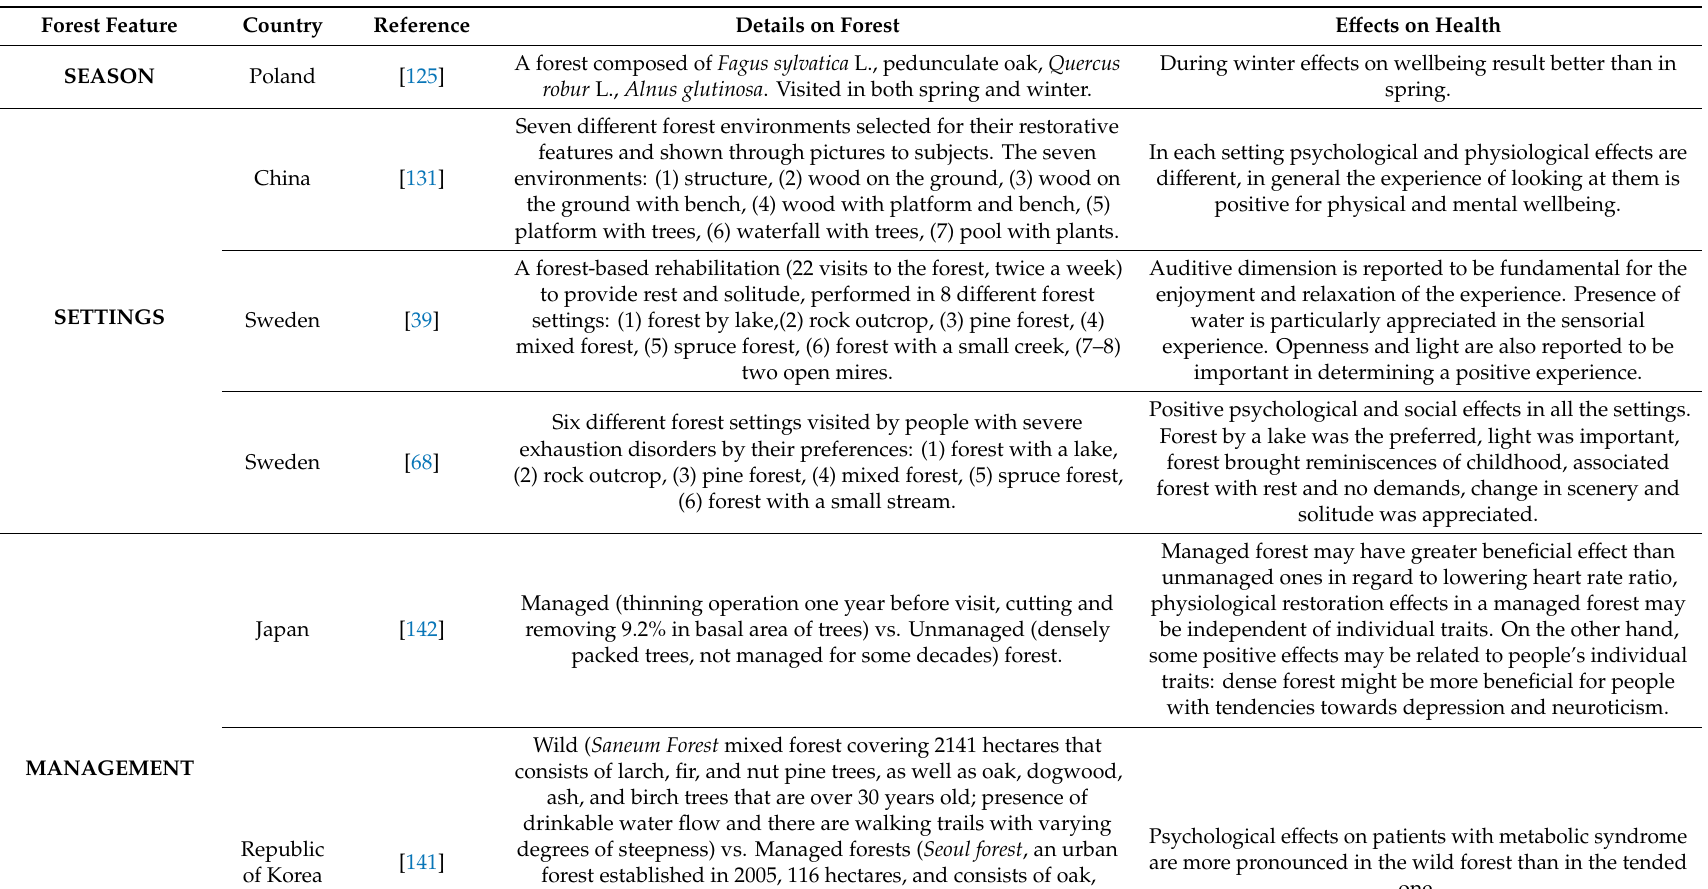
Table 2. Findings on forest